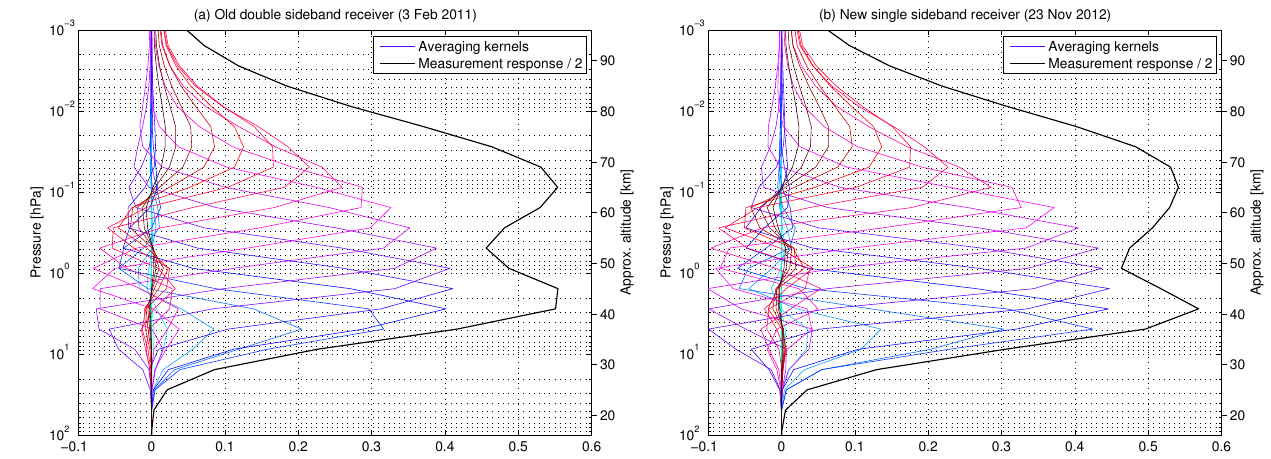
Figure 8. Typical sets of WIRA wind averaging kernels and measurement response for the old double sideband (left) and the new single sideband receiver